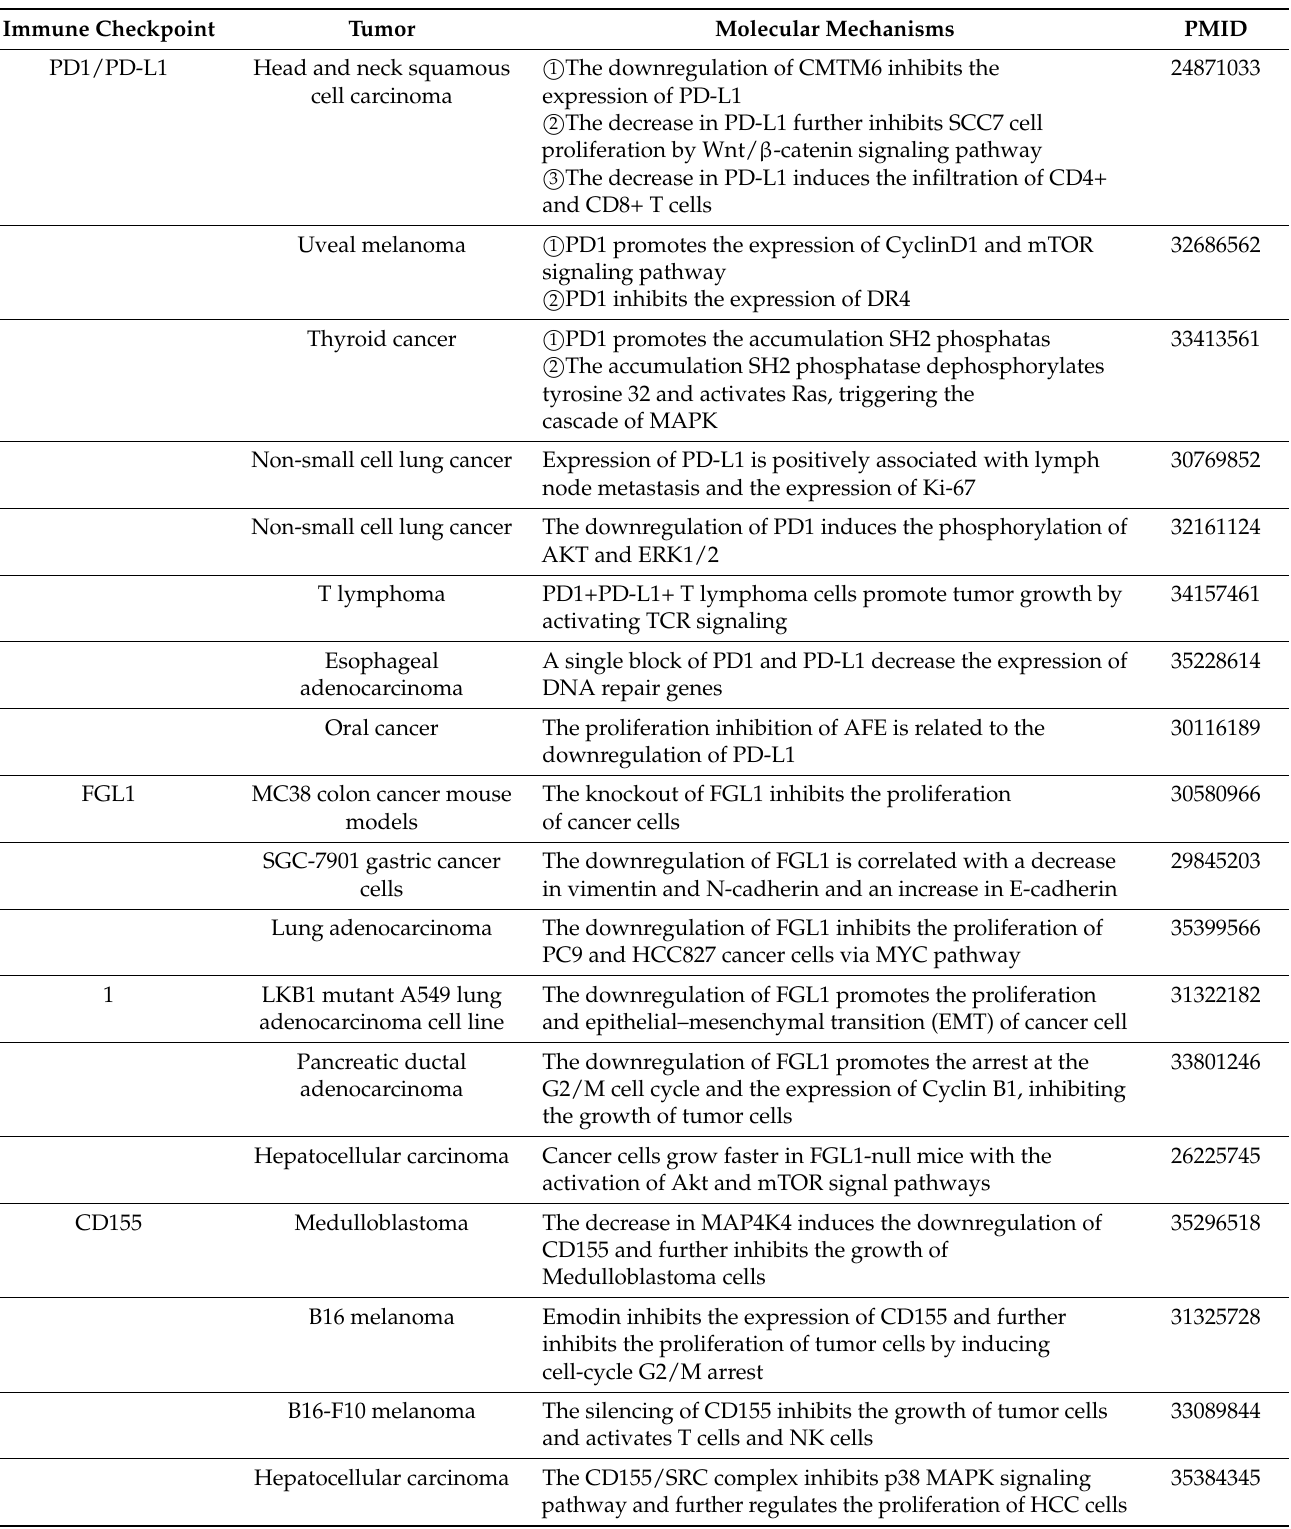
Table 1. Molecular mechanisms of immune checkpoints regulating tumor